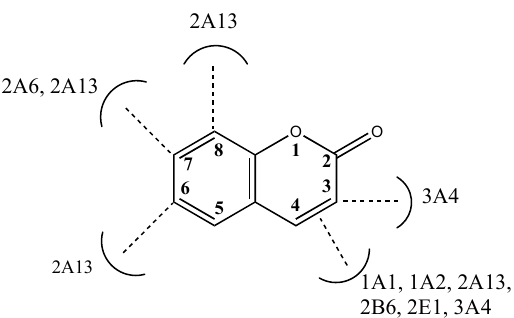
Figure 10. Oxidation of coumarin at various positions by di ff erent cytochrome P450 enzymes [78–87]. Coumarin is the marker substrate for the cytochrome P450 2A family, consisting of P450s 2A6